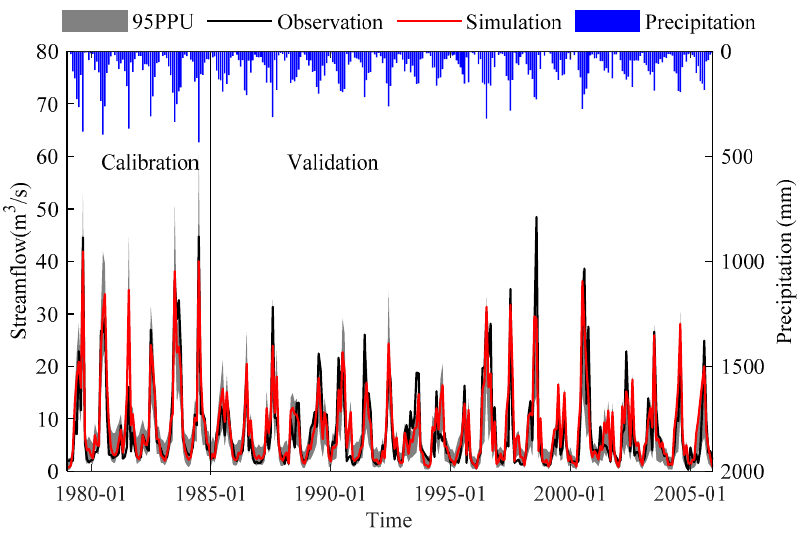
Figure 6. Simulated and observed streamflow and corresponding monthly precipitation for the calibration (1979–1984) and validation (1985–2005).